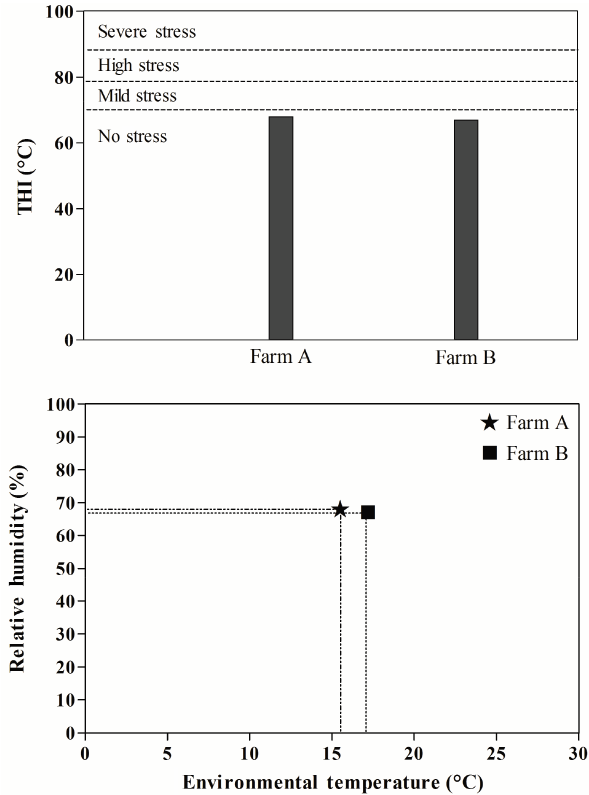
Figure 1. Temperature–humidity index (THI) values calculated for Farm A and Farm B with the respective environmental